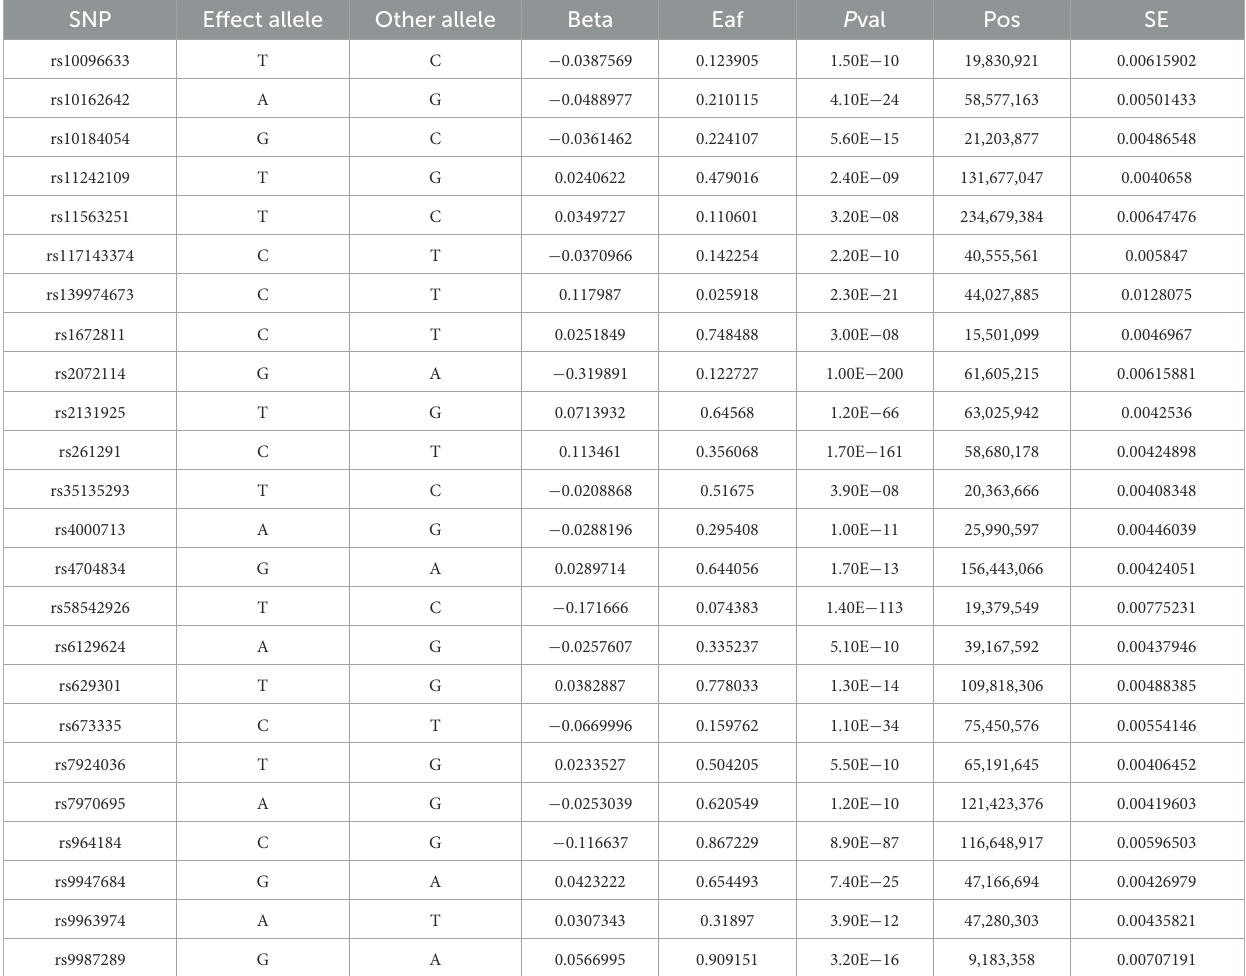
TABLE 1 Detailed information of IVs used in MR